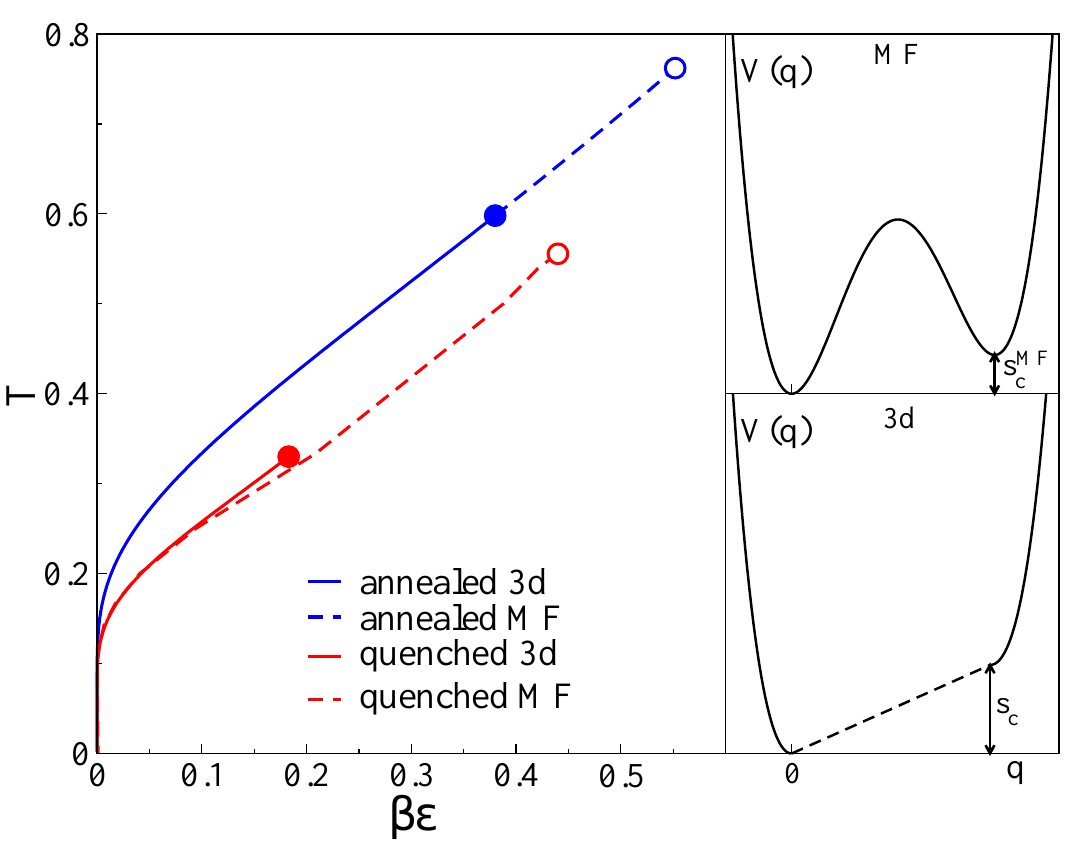
Figure 1: Temperature T versus coupling βε phase diagram of the square-pyramid model (SPyM) in both the annealed and the quenched descriptions for the Bethe hyper-lattice with c = 5 (dashed lines) and for d = 3 (full lines [ 11, 12 ] ). The transition lines are between a high- T phase with low overlap and a low- T phase with high overlap. The interaction strength J is set equal to 1. Inset: Sketch of the Franz-Parisi potential V ( q ) as a function of the overlap in the mean-field description (left) and for d = 3